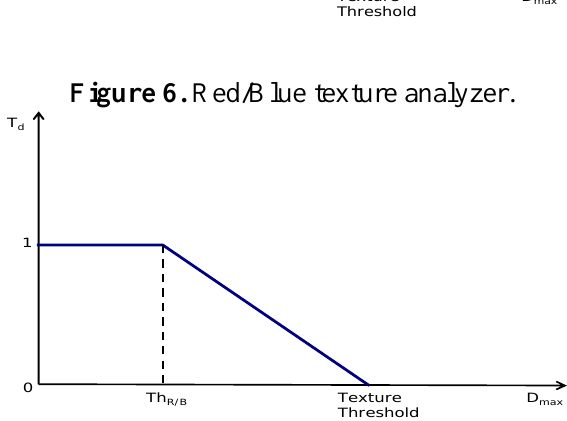
Figure 6. Red/Blue texture